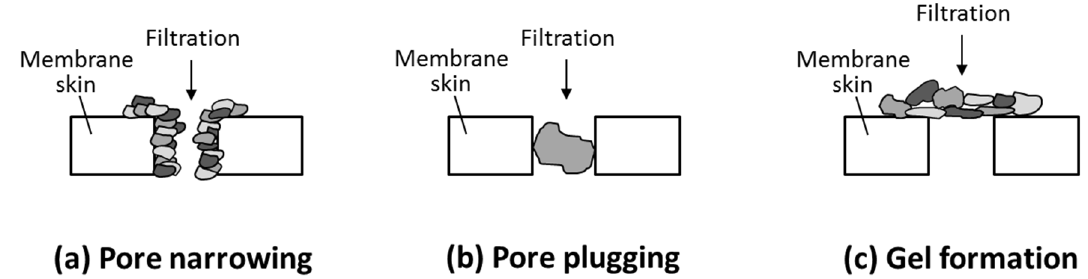
Figure 9. Mechanisms of membrane fouling: ( a ) pore narrowing; ( b ) pore plugging; and ( c ) gel